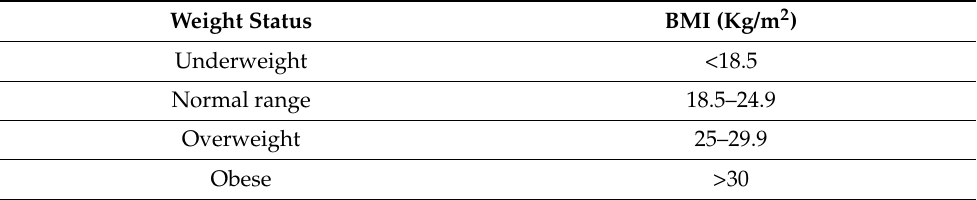
Table 1. Body Mass Index (BMI) and weight classification status. Adapted from Yang Q et al and Doll S et al. [1,2].